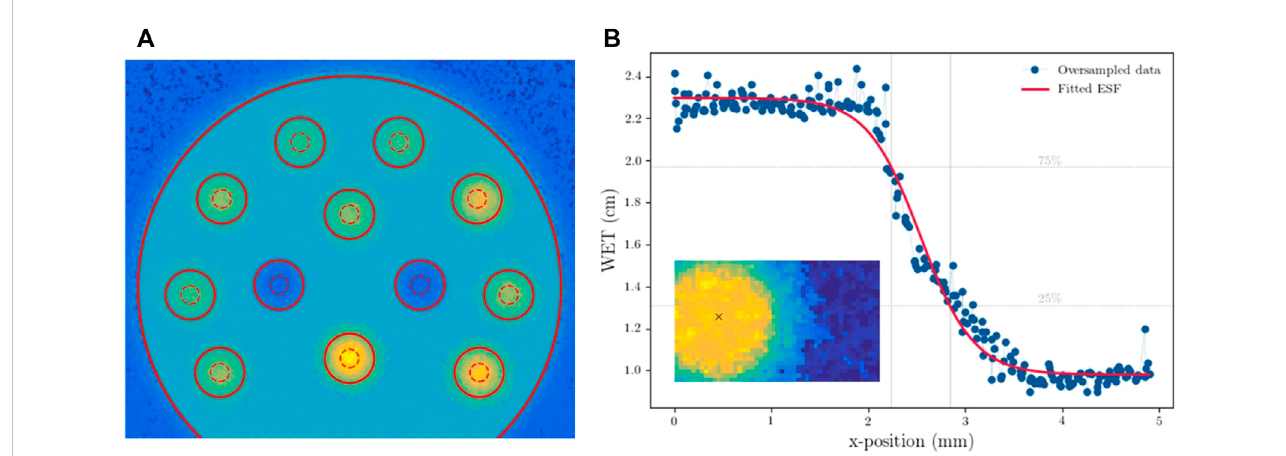
FIGURE 7 (A) Marginsfromtheinsertedge(continuouscircle)totheevaluatedROI(dottedcircleinside)forWETaccuracyandprecisioninaregionoftheimagenot blurred by scattering. (B) Combined line pro fi les at the edge of the SB3 cortical bone insert (depicted on the bottom left) to fi t the edge-spread function and calculate the spatial resolution.